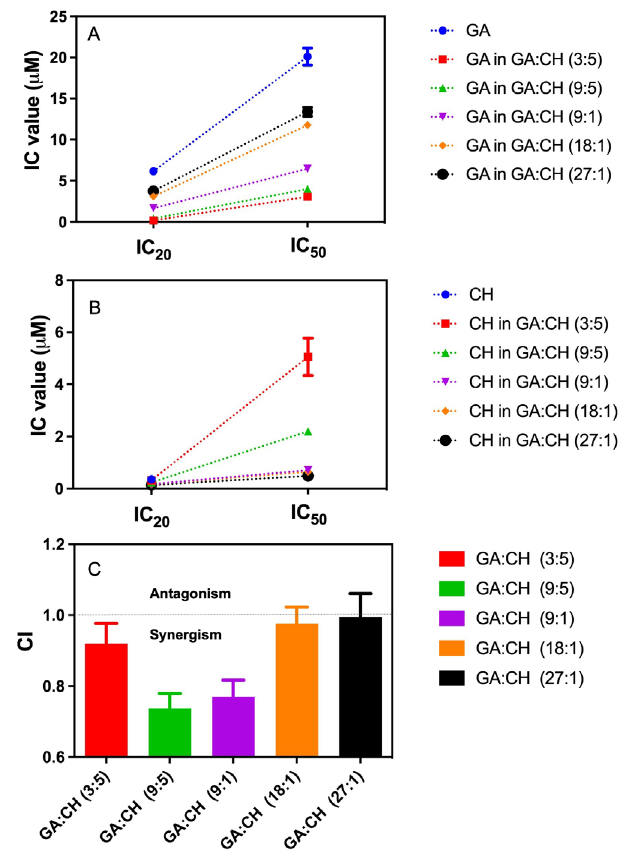
Figure 5. IC values of ( A ) GA and ( B ) CH in combined mixtures of different molecular ratios, and ( C ) CI value of GA:CH combinations at the inhibition level of 20% (IC 20 ). GA, gallic acid; CH, catechin hydrate; IC, inhibition concentration; CI: combination index.